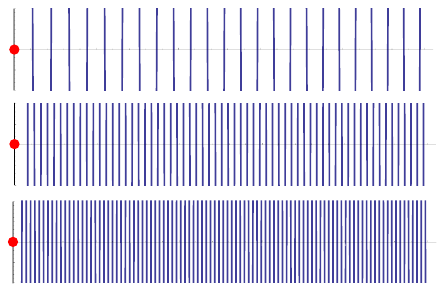
Figure 10 . Frequency spectrum K i! ( (cid:15) ) = 0 as (cid:15) ! 0. The spectrum becomes more and more dense, with the exception of ! = 0, which is never included in the physical spectrum with zero electric (cid:12)eld on the